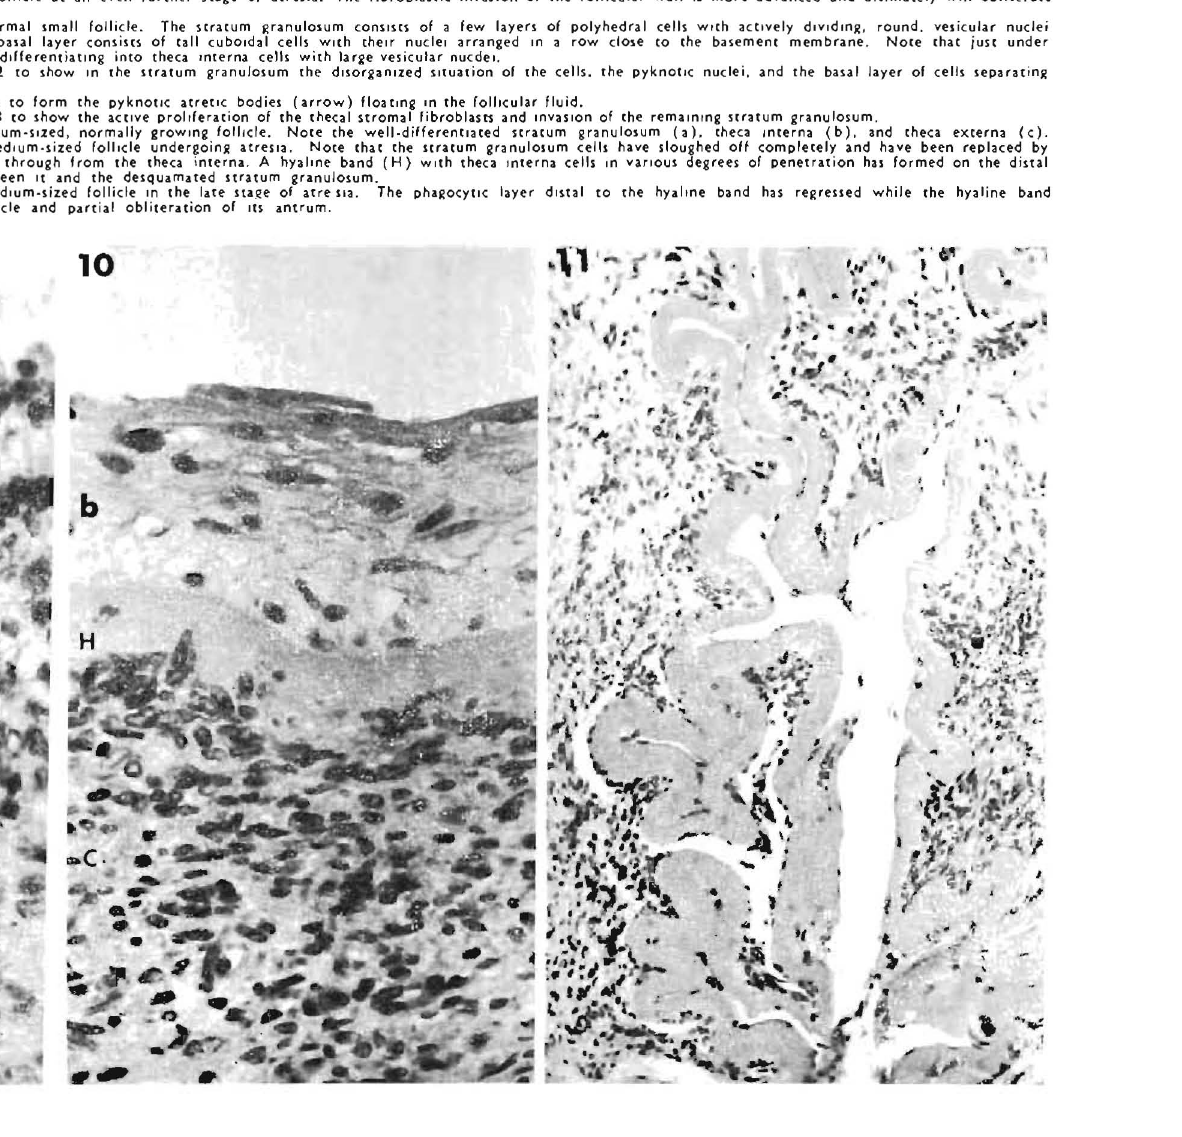
Fig. 4: (X 80) Section of the wall of a small follicle at an even further stage of atresia. The fibroblastic invaSion of the follicular wall IS more advanced and ultimately will obliterate the antrum. Fig. 5: (x 511) A section of the wall of a normal small follicle. The stratum Rranulo:lium comlsu of a few layers of polyhedral cells With actively d,v,dlnji/. round. ve:liicular nuclei surrounded by a fair amount of cytoplum. The baul layer consisu of tall cubOidal cells With their nuclei arranged In a rOw clo:lie to the basement membrane. Note that just under these cells a few stromal thecal cells have beiun differentiating into theca ,nterna cells with large vesicular nucdel. Fig. 6: (x 511) A higher magnification of Fig 1 to show In the stratum granulosum the disorganized situation of the cells. the pyknotiC nuclei. and the basal layer of cells separatinji/ from the bnement membrane. Fig. 7: (x511) Sloughing of the granulosa cells to form the pyknotiC atretic bodies (arrow) floating In the follicular fluid. Fig. 8: ( x 511) A higher magnification of Fig. 3 to show the active proliferation of the thecal stromal fibroblasts and InVaSion of the remaining stratum iranulosum. Fig. 9: ( x 511) A section of the wall of a medlum,slzed, normally growing follicle. Note the well·differentlated stratum granulo:lium (a). theca Interna (b), and theca externa (c). Fig. 10: ( x 511) A ~ectlon of the wall of a medlum·sized follicle undergoinji/ atreSia. Note that the seracum granulosum cells have sloughed off completely and have been replaced by 01 layer of phOlgOCytlc cells which have penetrated through from the theca interna. A hyalrne band (H) With theca .ncerna cells In vanous degrees of penetration has formed on the distal upect of the theca Interna (below H). I.e. between It and the desquamated stratum granulosum. Fig. 11: ( x 511) A section of the wall of a medium-sized follicle In the late sta.,<e of atresia. The phaji/ocytlc layer distal to the hyaline band has reRressed while the hyaline band iuelf has contracted causing collapse of [he follicle and partial obliteration of Its antrum.